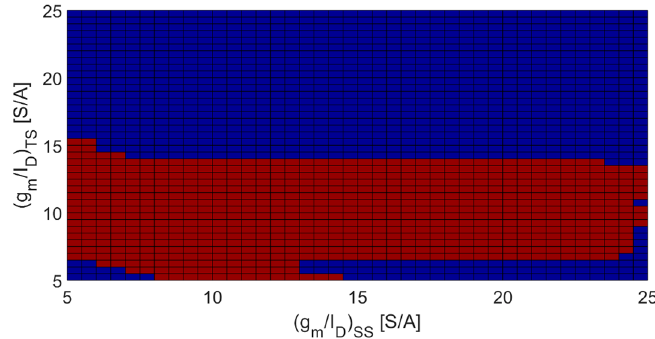
Figure 5. Solution space versus g m / I D(TS) and g m / I D(SS) ratios.